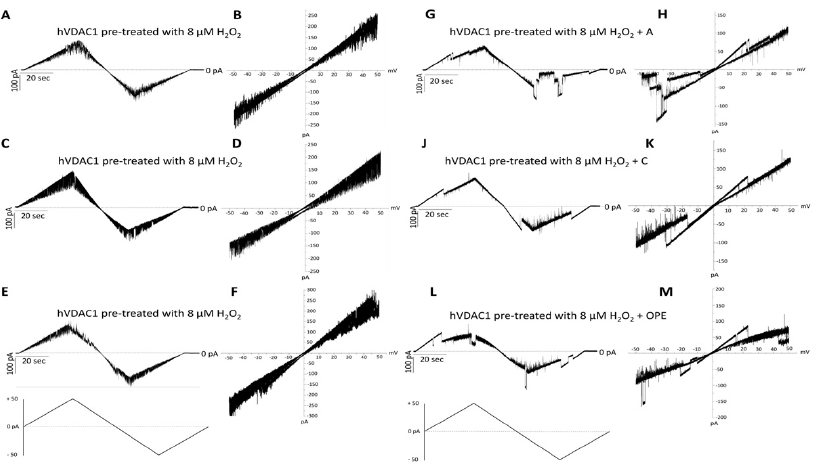
Figure 3. Analysis of the effect of tested samples on hVDAC1 voltage dependence following hydrogen peroxide treatment by triangular voltage ramps. Sample A (panels ( G , H )), sample C (panels ( J , K )) and sample OPE (panels ( L , M )) were added to both sides of a DiphPC bilayer containing hVDAC1 pre-treated with 8 µM H 2 O 2 (panels ( A – F )) at a final concentration of 1:100 ( v / v ). Current measurements were performed in symmetrical 1 M KCl upon application of a triangular voltage ramp of ±50 mV. The corresponding I–V plots were obtained by plotting the current as a function of clamp voltage.